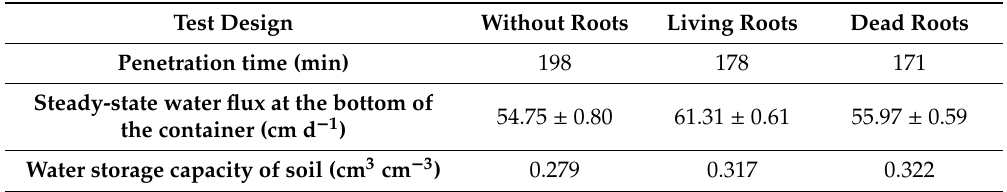
Table 2. Penetration time, steady-state water flux at the bottom of container, and water storage capacity of soil without or with living and dead roots.